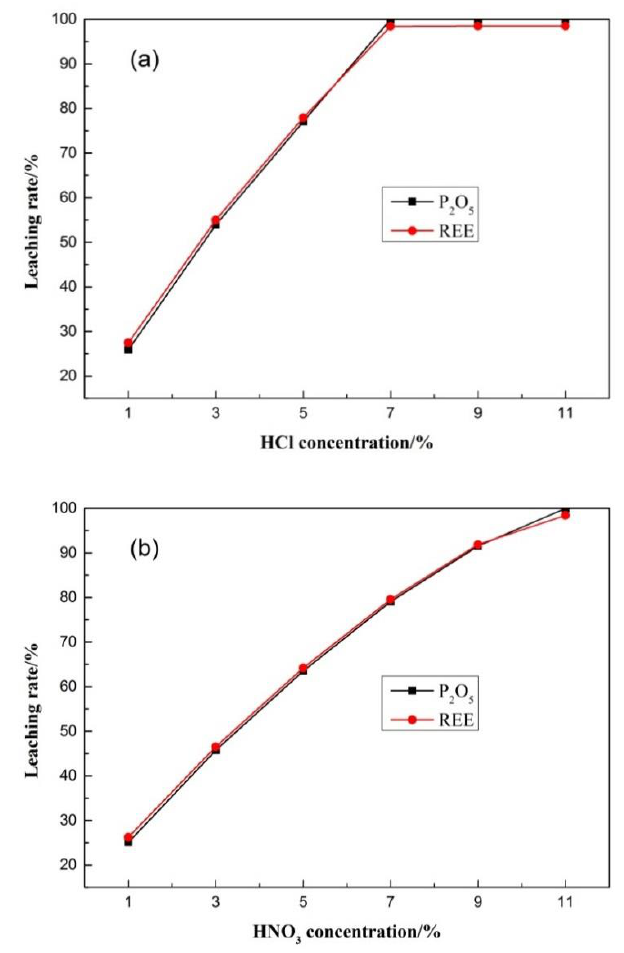
Figure 5. Results of acid leaching test. ( a ) HCl leaching test; ( b )HNO 3 leaching test.